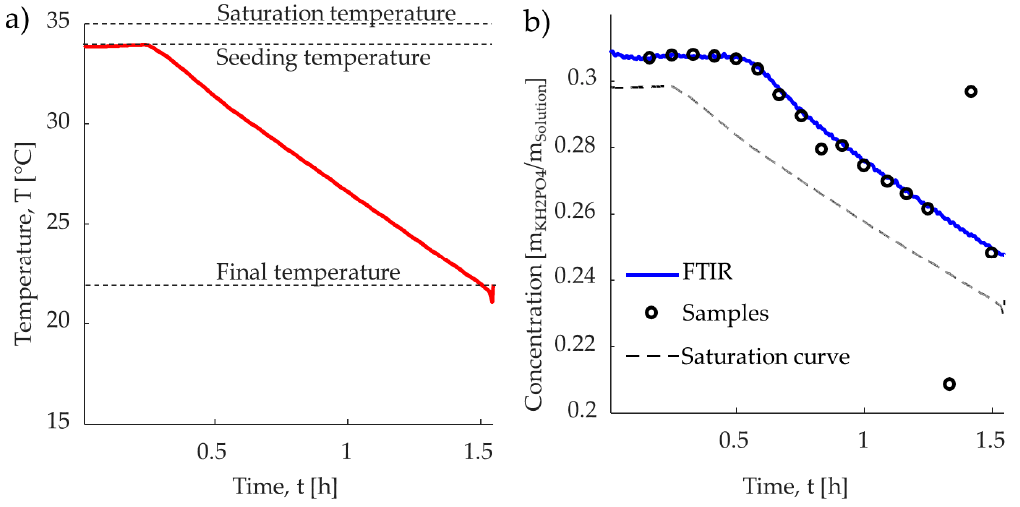
Figure 4. ( a ) Temperature profile of Exp. 3—KH 2 PO 4 : saturation, seeding, linear cooling ramp, and final temperature. ( b ) Concentration profile of Exp. 3—KH 2 PO 4 : FTIR, offline samples, and saturation curve.